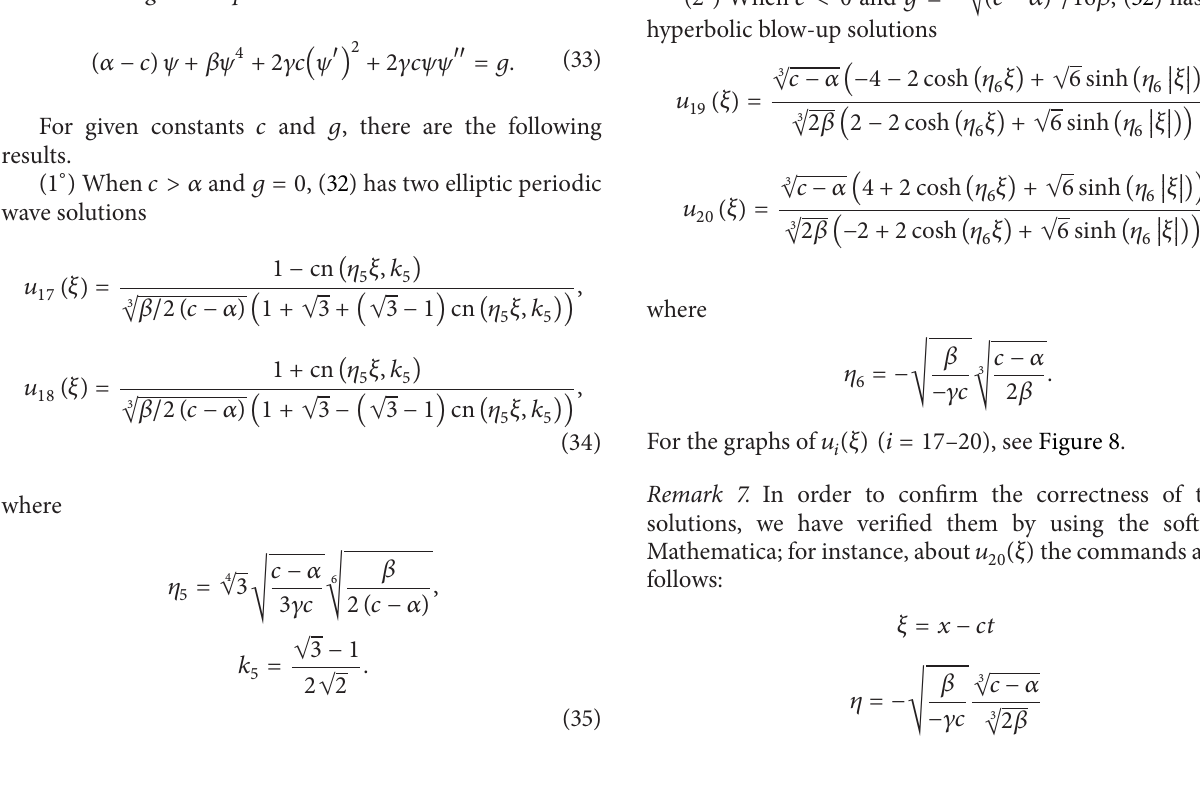
and its traveling wave